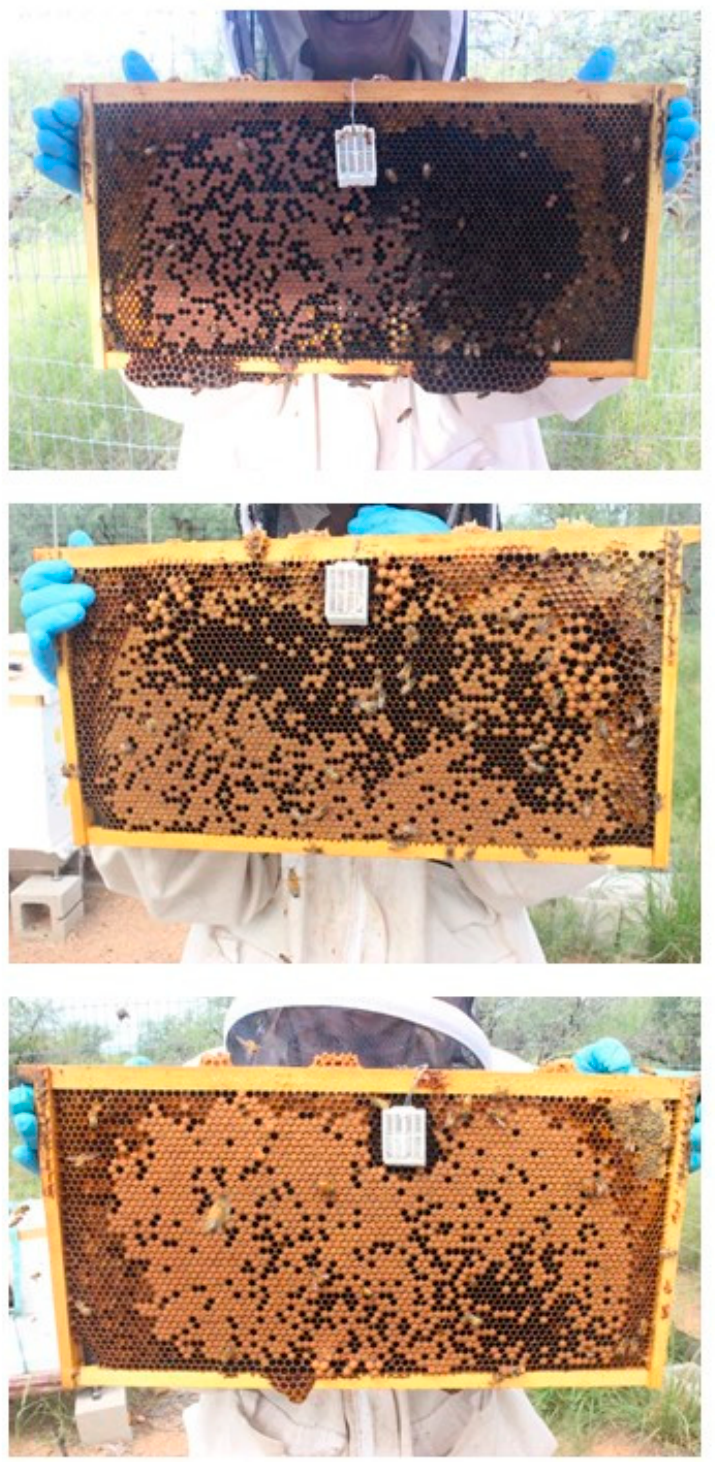
Figure 1. Examples of photographs of brood frames, including temperature sensor, taken on 6 September 2019, after the end of the treatment period. Top photo: Control treatment; middle photo: Low (50 ppb) exposure to flonicamid; bottom photo: High (250 ppb) exposure to flonicamid.